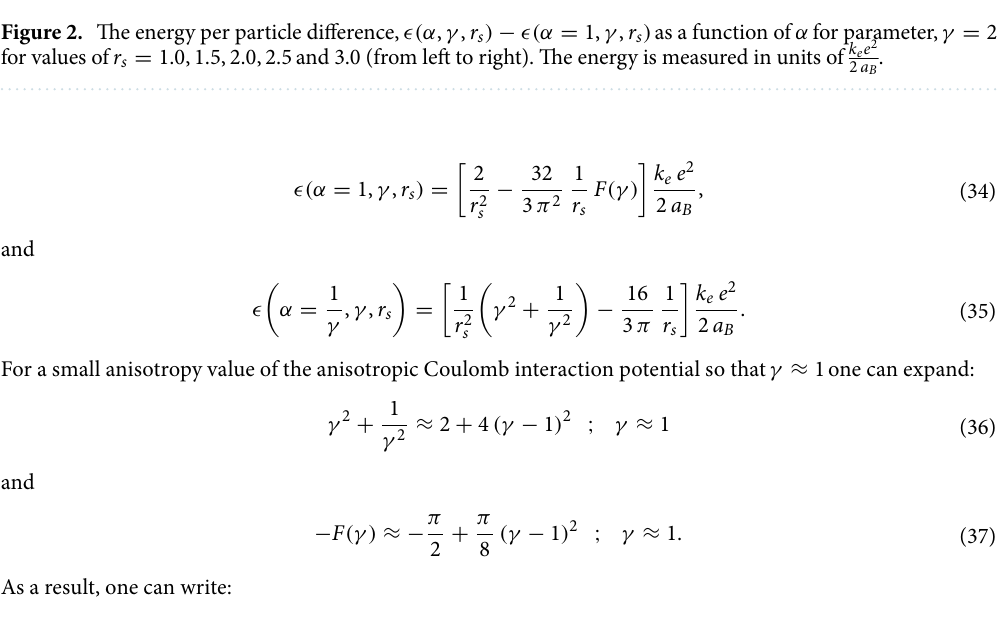
1, γ , r s ) as a function of α for parameter, γ ǫ(α − =